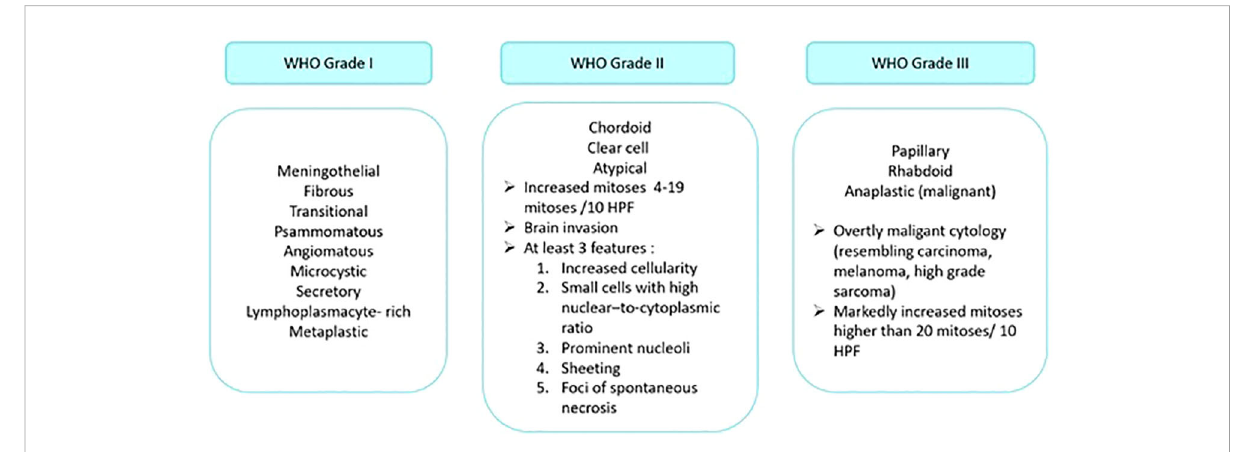
FIGURE 2 Grading of meningiomas according to the 2021 WHO classi fi cation system. HPF: high power fi eld.